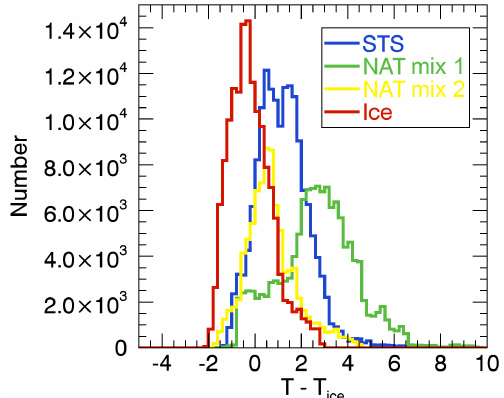
Figure 6. Occurrence histogram of ice, NAT Mix2, NAT Mix1 and STS of the 22 January 2016 PSC (Fig. 5) versus temperature differ- ence to T ice